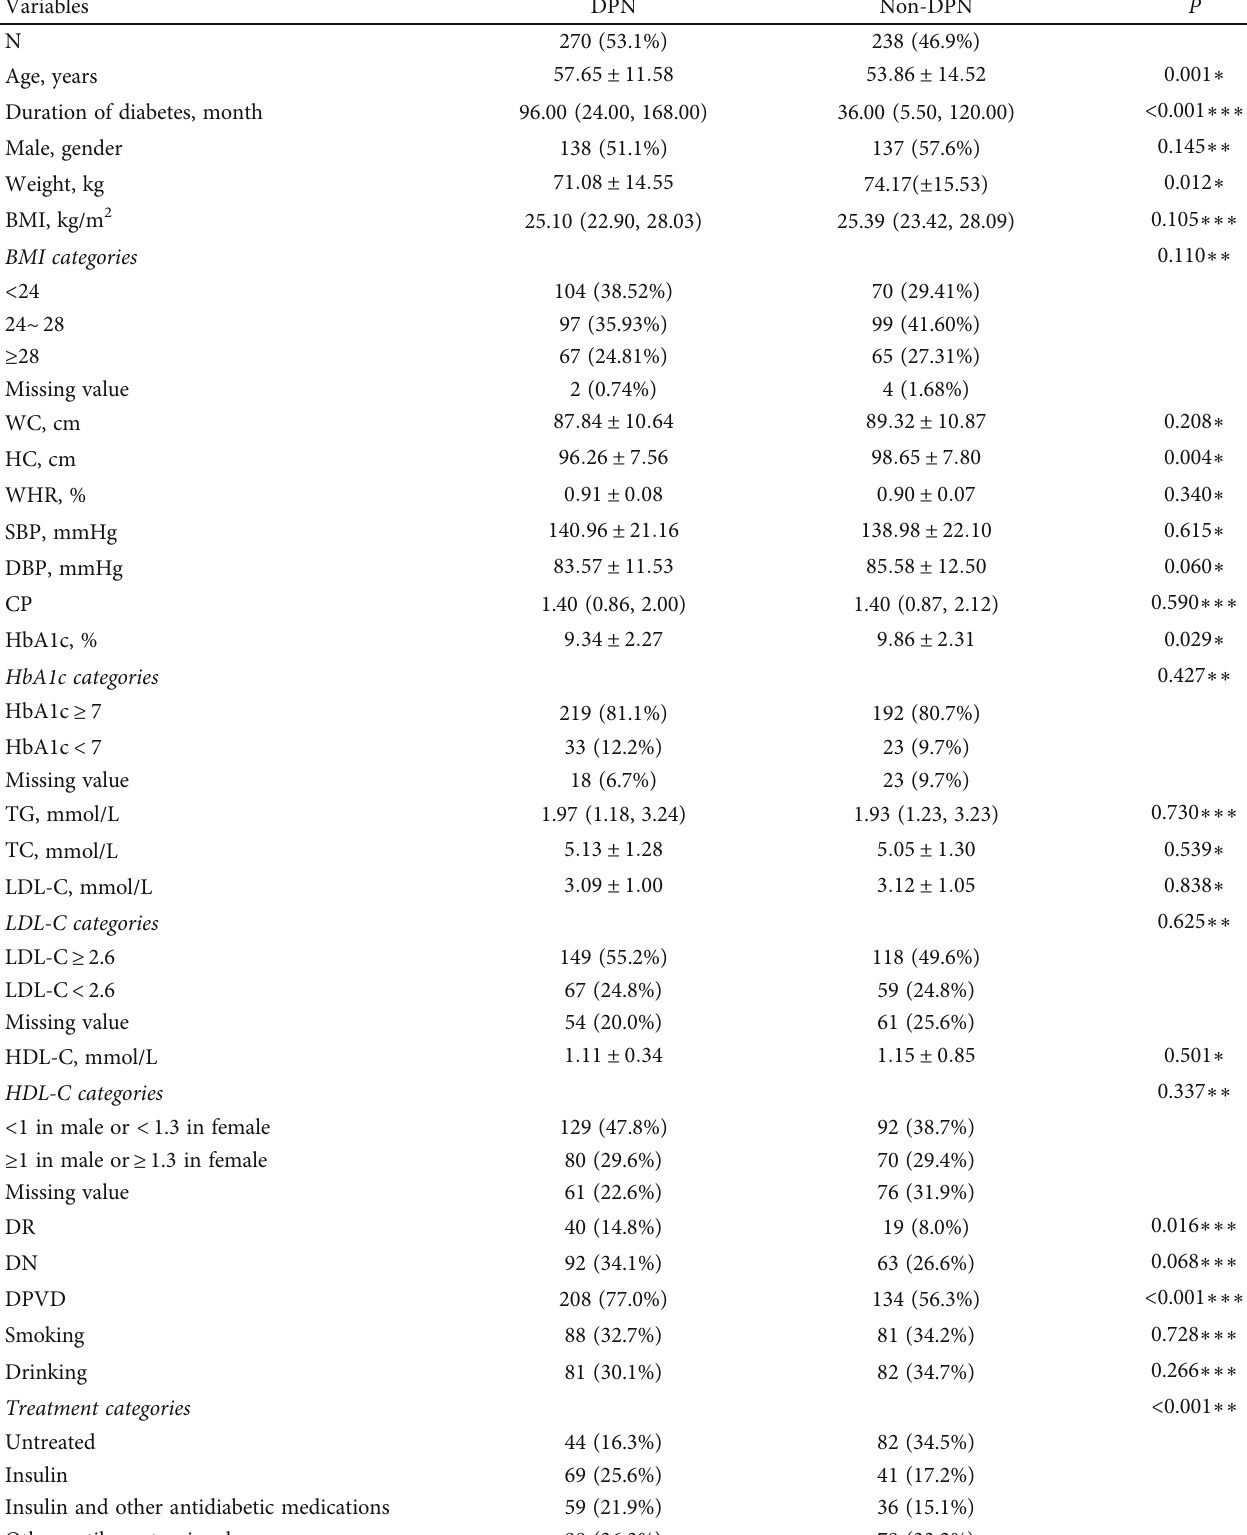
Table 1: Population and clinical characteristics of patients with